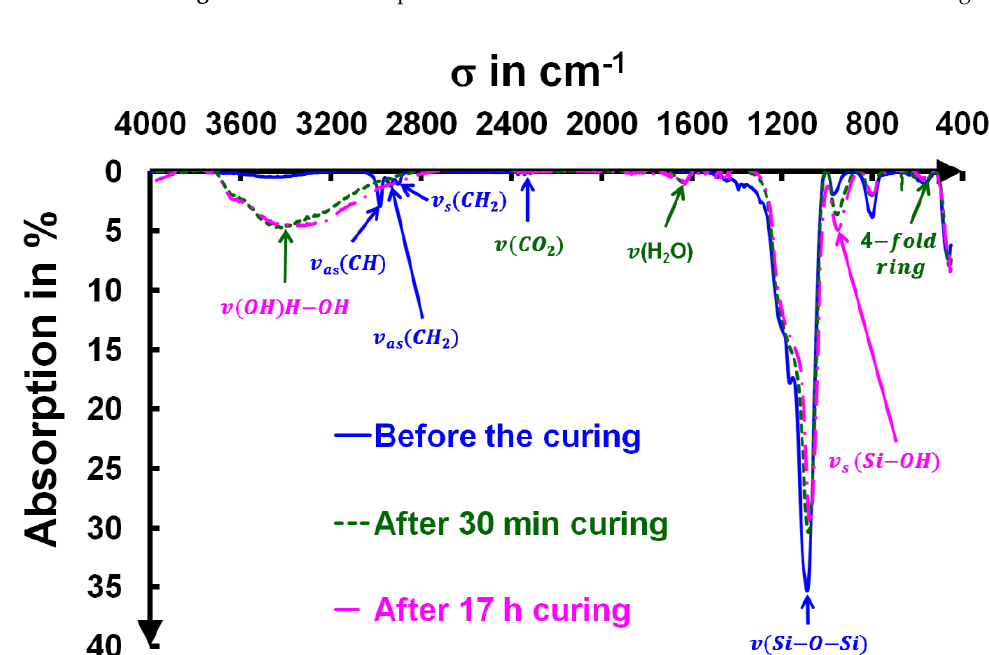
Figure 1. Schematic representation of the chemical evolution of ammonia curing.